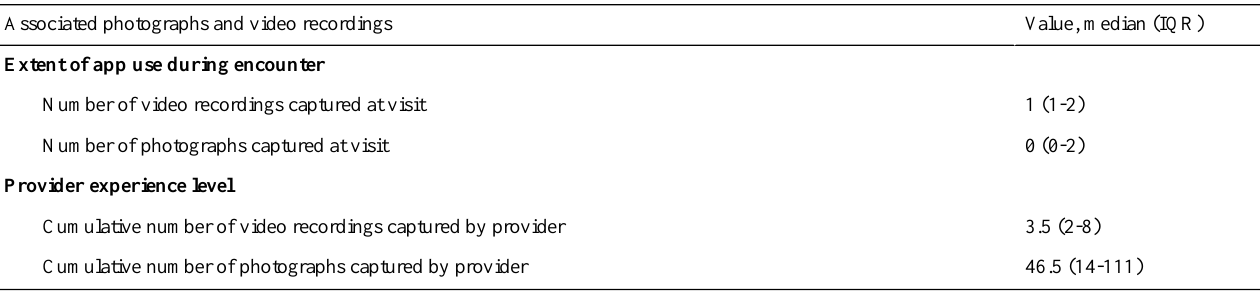
Table 2. Photographs and video recordings associated with each clinical encounter and provider experience level at the time of use.